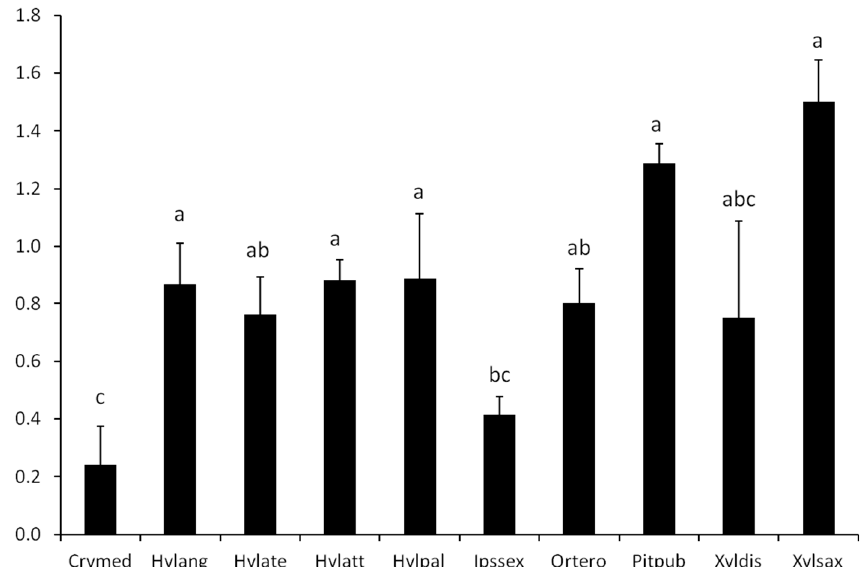
Figure 3. Fungal species richness on the exoskeleton of the different bark beetle species (Crymed = C. mediterraneus , Hylang = H. angustatus , Hylate = H. ater , Hylatt = H. attenuatus , Hylpal = H. palliatus , Ipssex = I. sexdentatus , Ortero = O. erosus , Pitpub = P. pubescens , Xyldis = X. dispar , Xylsax = X. saxeseni ). Different letters represent significant differences ( p < 0.05). Error bars represent standard errors.